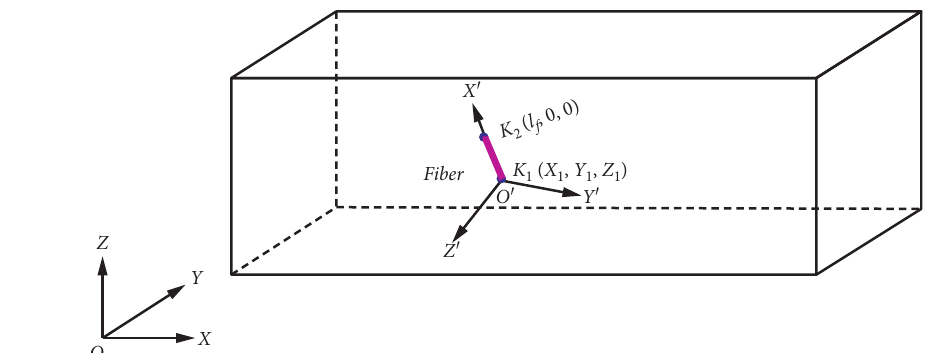
Figure 1: Generation of a fibre.